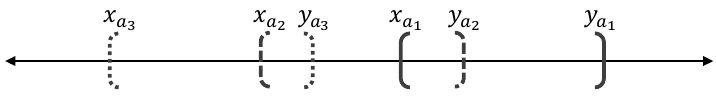
Figure 4. Relation of preference between intervals, adapted from [48].